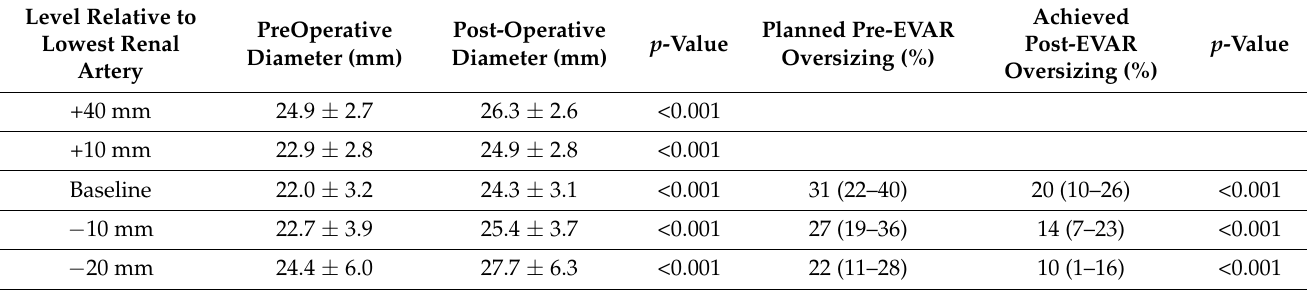
Table 3. Aortic neck diameters and oversizing measured on the preoperative and first postoperative computed tomography scans.